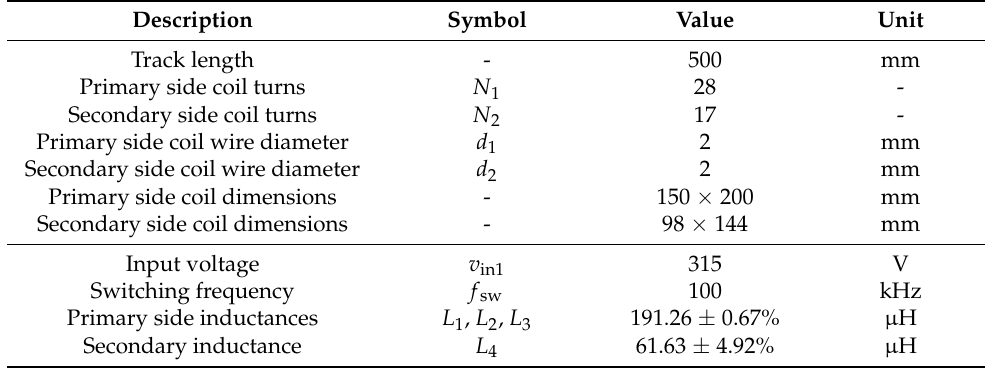
Figure 7. Simulation results of transmitter coil activation: ( a ) losses due to resistor R l 1 , R l 2 and R l 3 values; ( b ) input currents i 1 , i 2 and i 3 ; ( c ) input currents i 1 , i 2 and i 3 for the first coil activated; ( d ) input currents i 1 , i 2 and i 3 for the second coil activated; ( e ) input currents i 1 , i 2 and i 3 for the third coil activated; ( f ) output current i 4 for the first coil activated; ( g ) output current i 4 for the second coil activated; ( h ) output current i 4 for the third coil activated.